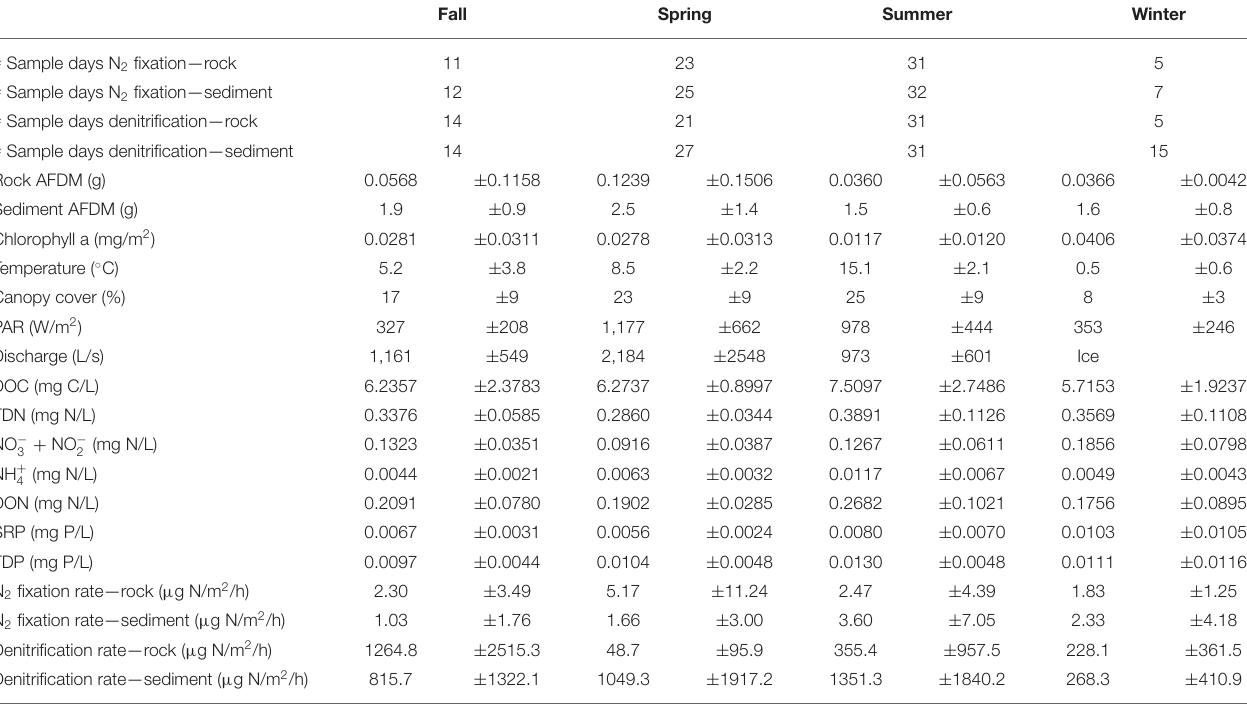
Fall Spring Summer